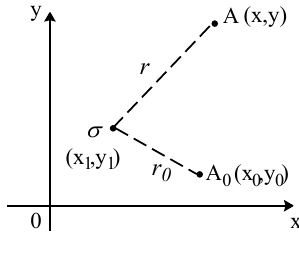
Figure 1. The 2D calculation method of infinite line charge.